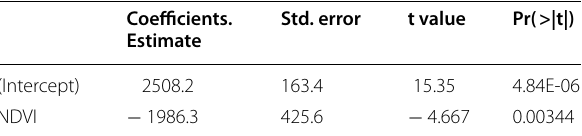
Table 10 Statistical estimates of the subset regression model for the linear regression model Coefficients.